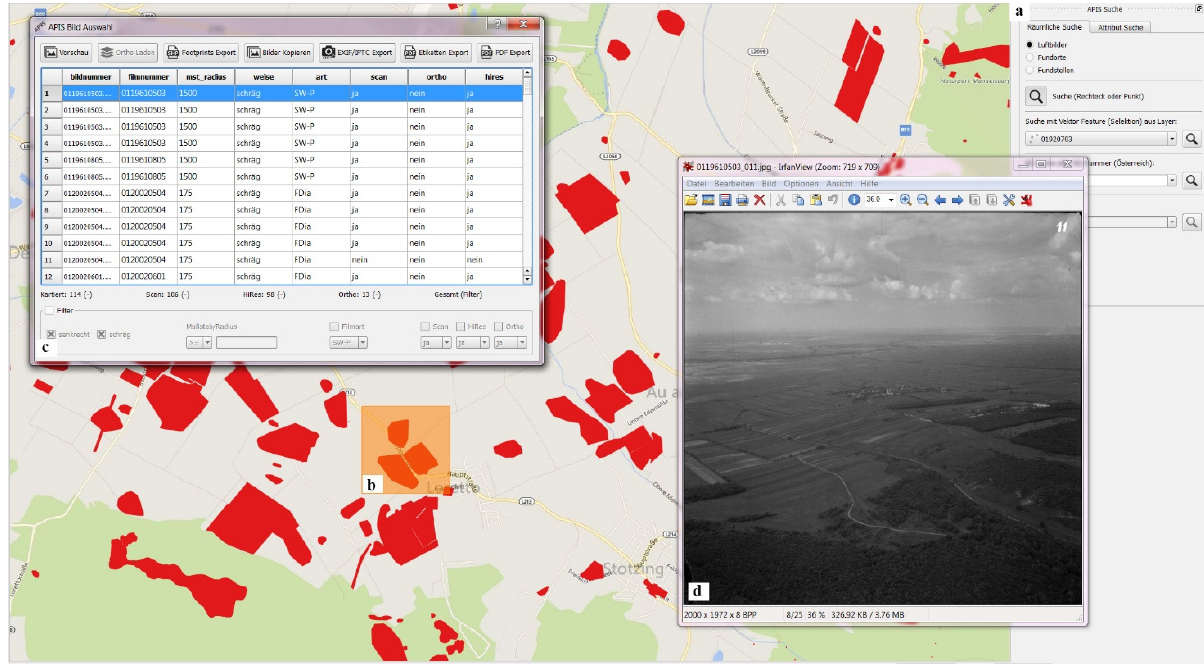
Figure 5: APIS: search procedure for aerial photographs. (a) filter (b) search polygon (c) list of aerial photographs within polygon area (d) scanned aerial photograph pops up when the respective entry from the list was double-clicked. Red polygons in the background delineate archaeological